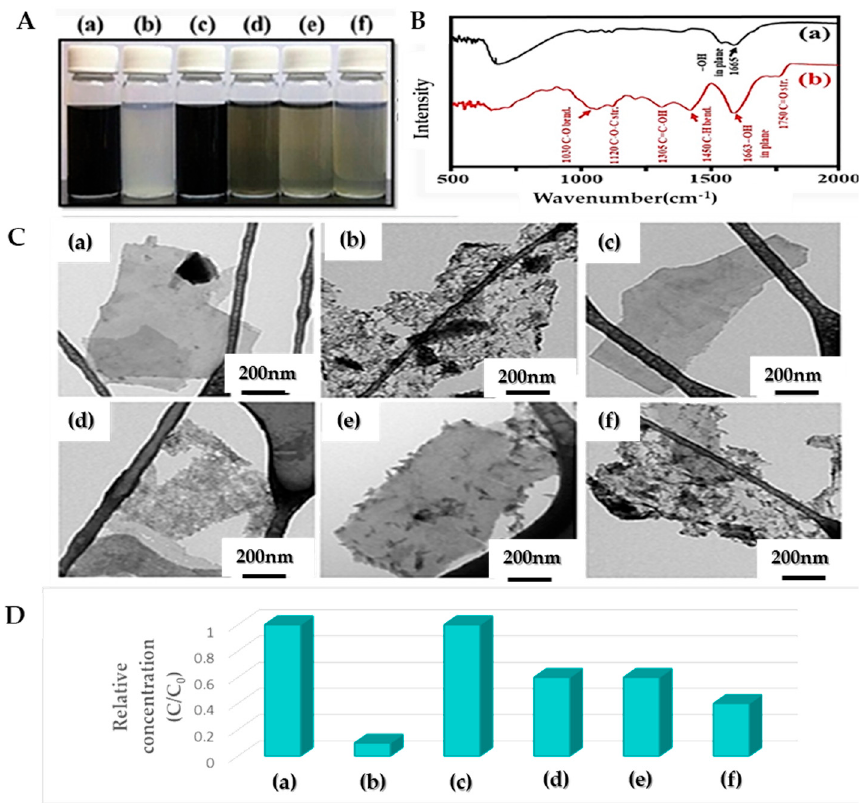
Figure 3. ( A ) Photographs, ( B ) FT-IR spectra, ( C ) TEM images, and ( D ) relative concentration (C/C0), ( a ) p-MXene-fresh, ( b ) p-MXene-80, ( c ) SA-MXene-80, ( d ) SC-MXene-80, ( e ) SOMXene-80, and ( f ) SP-MXene-80 suspension with the concentration 0.2 mg mL − 1 in terms of Ti 3 C 2 T x MXene. C0 and C in ( B ) represent the concentration of fresh and stored MXenes, respectively, reprinted with permission from [63] .